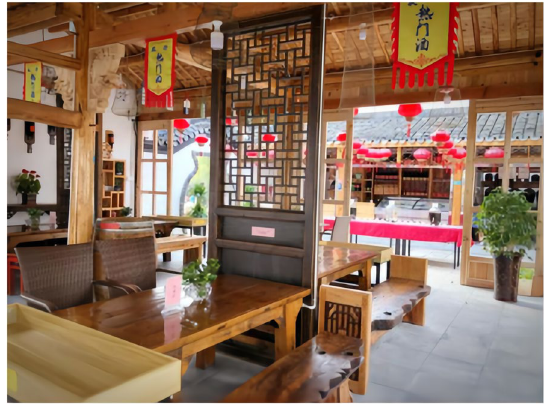
Fig. 5 The cultural symbols of the mulberry dyke and fish-pond systems (Source: the authors)